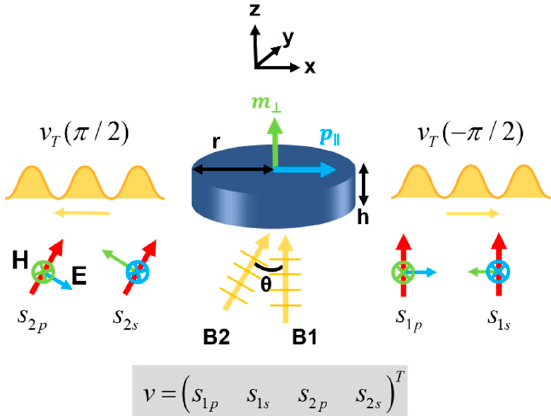
Figure 1 . Schematic of the coherent control approach. A nanodisk with radius r and height h is located at the origin of the Cartesian coordinate system. Two coherent beams illuminate normally (B1) and obliquely (B2) towards the nanodisk. The incident angle of the oblique beam is θ . The excitation state of the incident beams, according to their polarizations, can be expressed as a